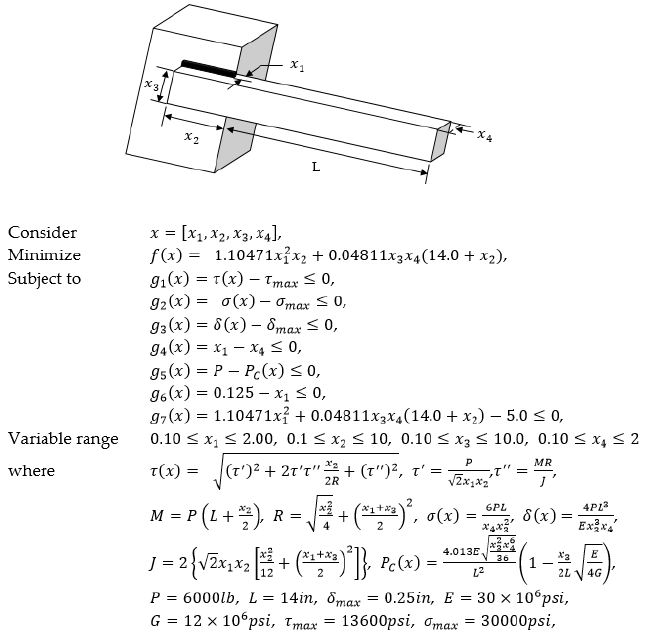
Figure 4. Welded beam design. Table 8. Parameters of compared harmony search (HS) algorithms in the welded beam design engineering problem.